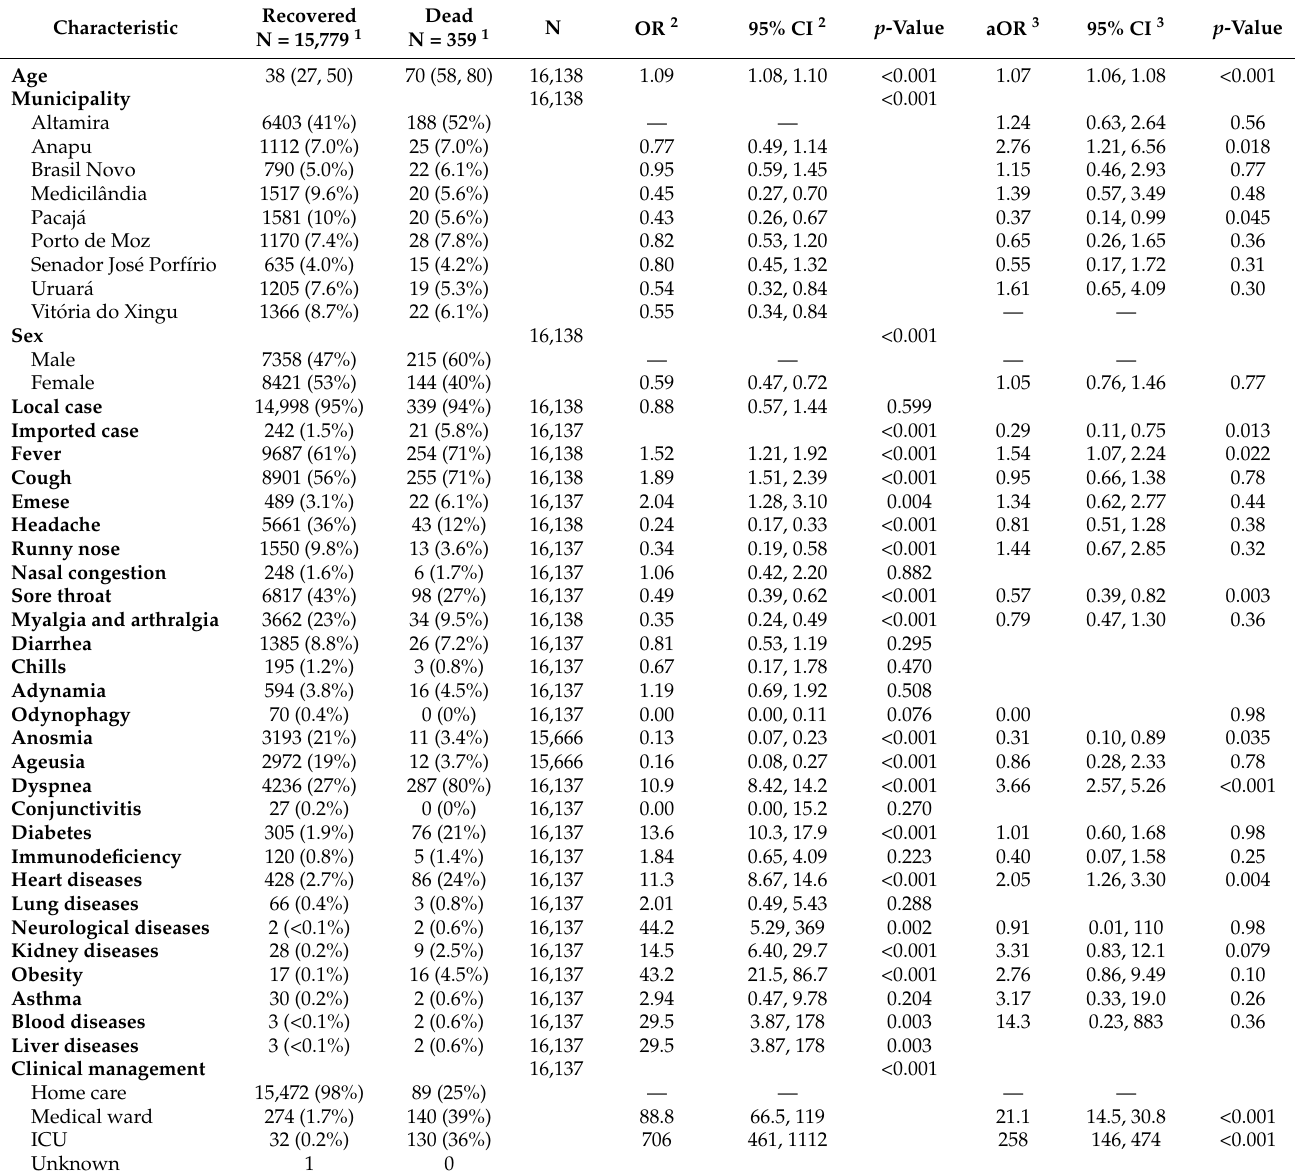
Table 5. Sociodemographic factors, symptoms and comorbidities as predictors of